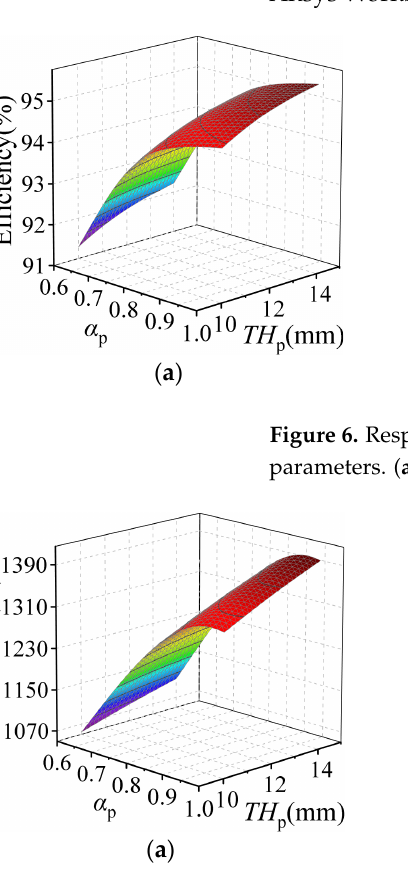
Figure 5. Fitted curve of the predicted and calculated values of the response surface.